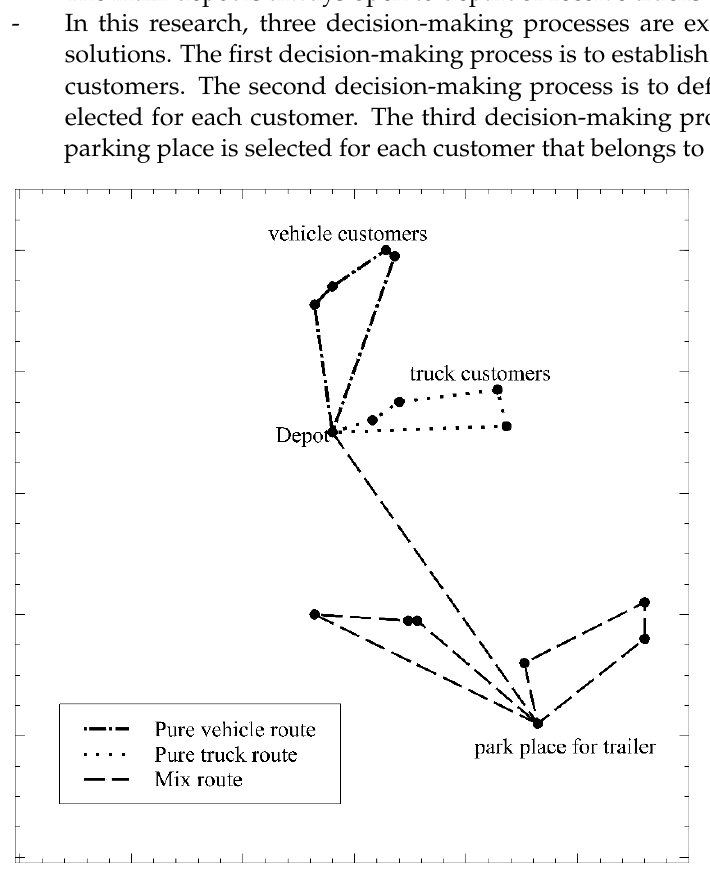
Figure 1. A truck and trailer routing example.